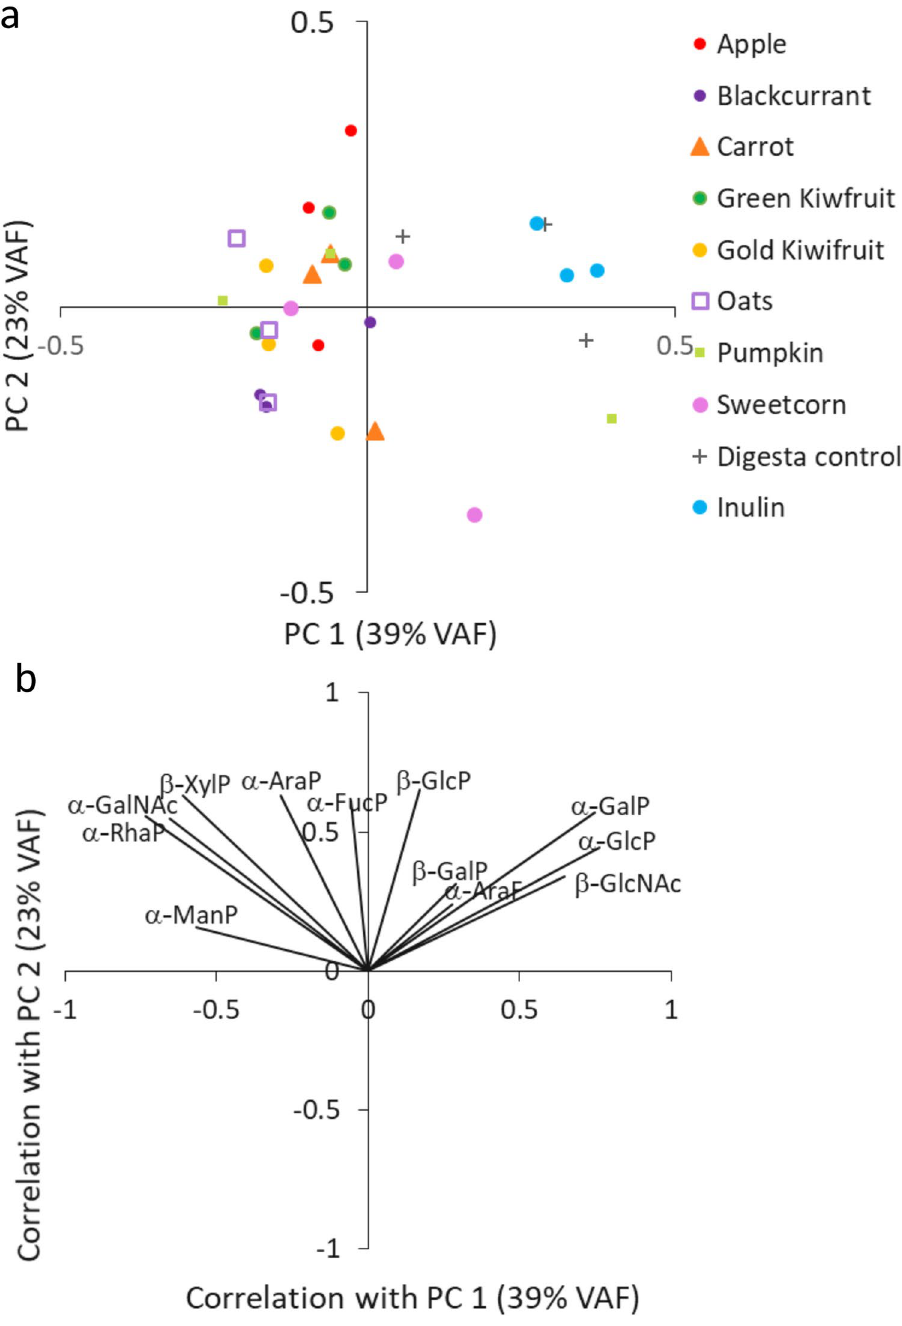
Figure 3. Principal component analysis plot ( a ) and the loadings plot ( b ) demonstrate microbial glycosidase- driven separation of foods and controls after 10 h of fermentation with infants’ faecal inocula. Each substrate was fermented in triplicate. The enzymes included α-arabinofuranidase (α-AraF), α-arabinopyranosidase (α-AraP), α-fucopyranosidase (α-FucP); α-glucopyranosidase (α-GlcP), β-glucopyranosidase (β-GlucoseP), α- and β-galactopyranosidase (β-GalP), α-N-acetylgalactosaminidase (GalNAc), β-N-acetylglucosaminidase (β-GlcNAc), α-rhamnopyranosidase (α-RhaP), α-mannopyranosidase (α-ManP) and β-xylopyranosidase